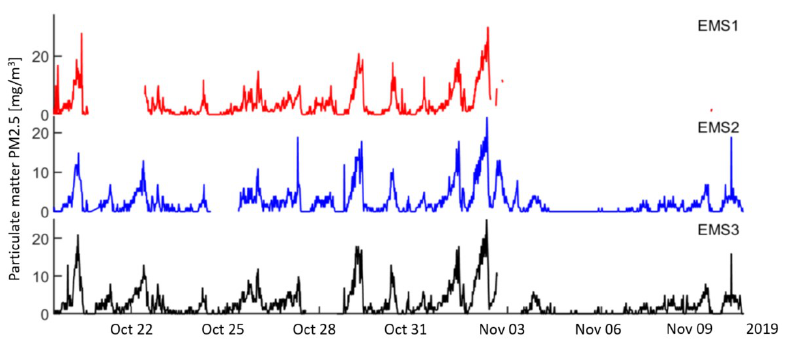
Figure 11. Data collected at three co-located sensor modules: EMS1, EMS2, and